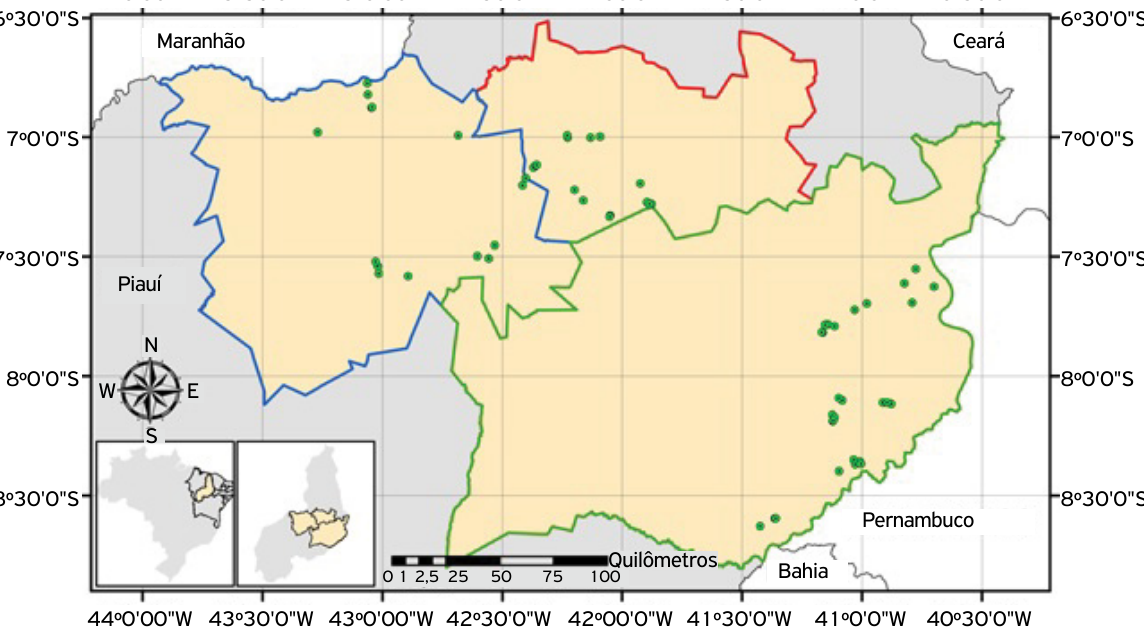
Figura 3. Localização georreferenciada das unidades produtoras de ovinos que participaram do estudo nas microrregiões do Alto Médio Canindé, Picos e Floriano, Piauí,